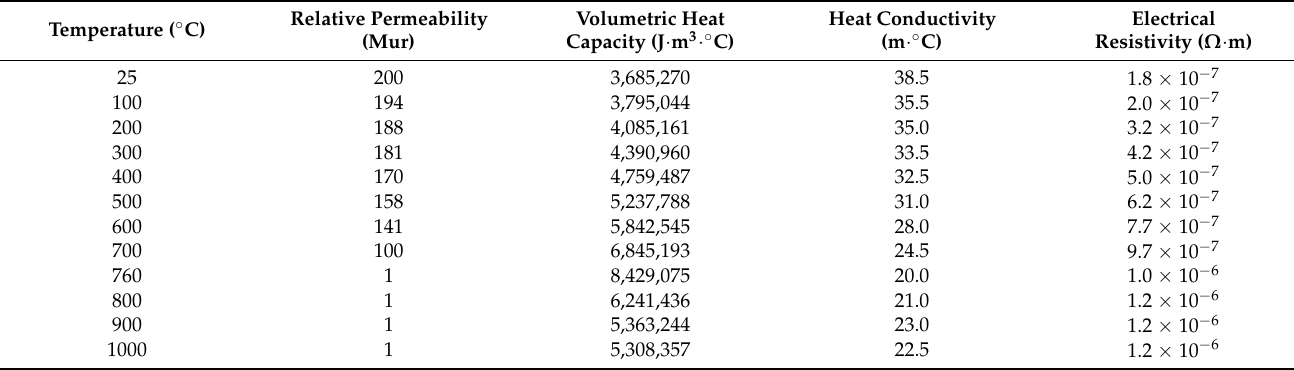
Table 1. Basic parameters of the